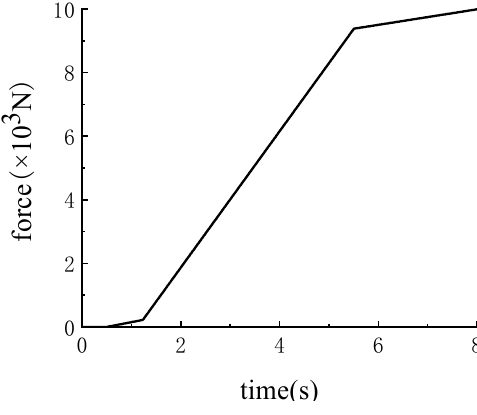
Figure 22. Variable slope pressure loading curve.